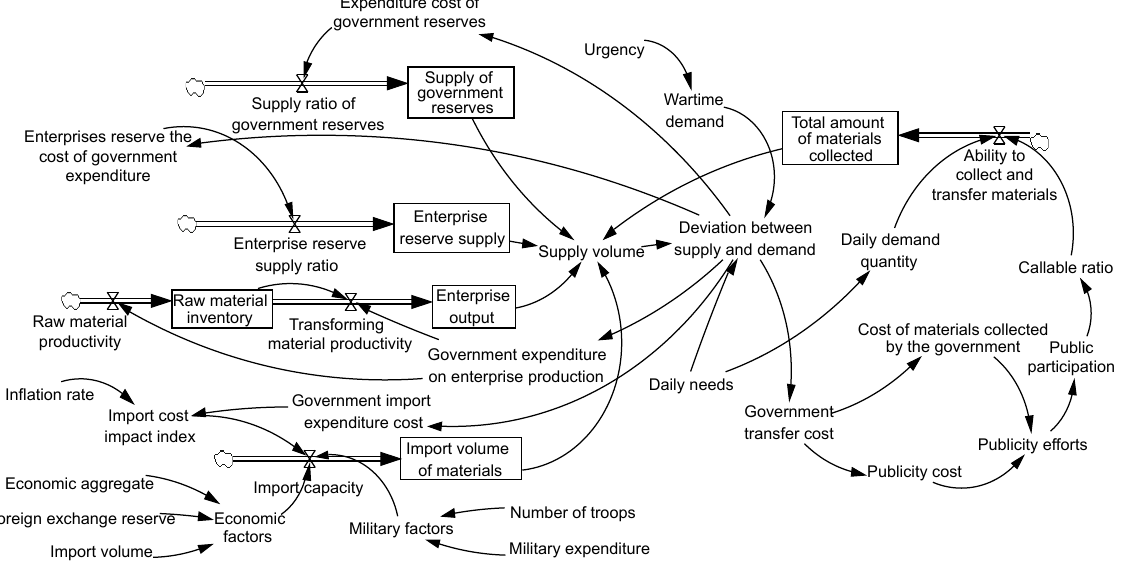
Fig. 3 Flow chart of the emergency material control system in peacetime and